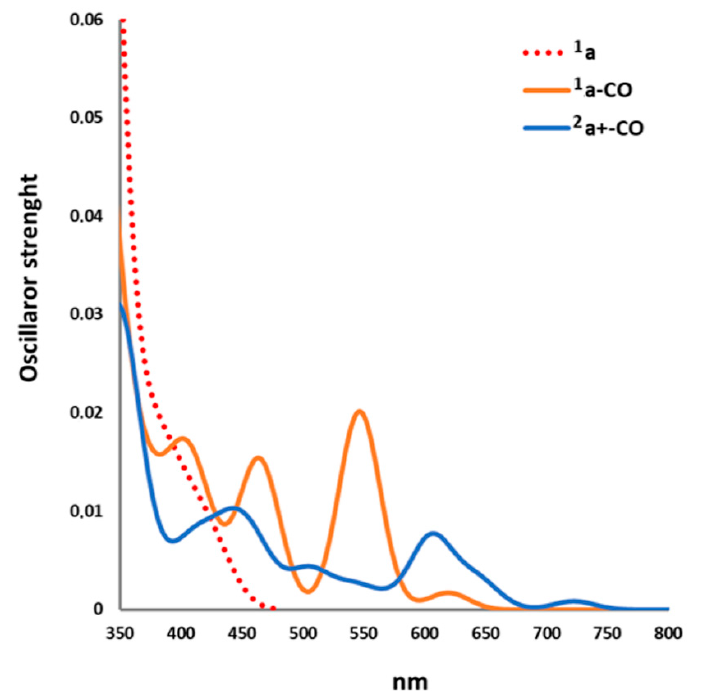
Figure 6. Time-dependent density functional theory (TDDFT) spectra of 1 a–CO and 2 a + –CO . The spectrum computed for a (ref. [33]) at the same level of theory is also reported for comparison. Stick spectra were first generated and then convoluted (solid line) using oscillator strength weighted Gaussian distribution functions centered on the computed excitation energies (nm) with halfwidths at half-maxima of 40 nm.